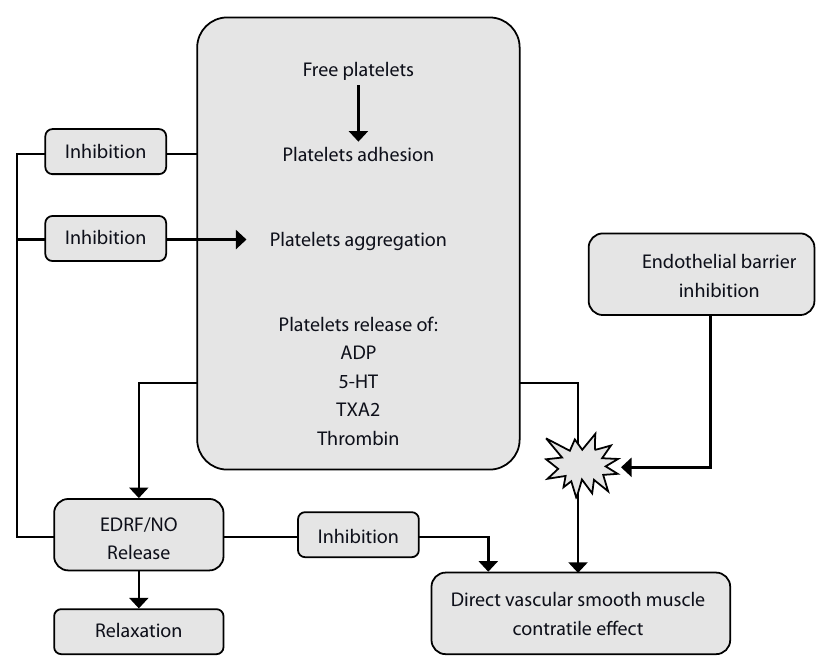
Fig. 3 - Vasodilator and antiplatelet actions of nitric oxide (NO).